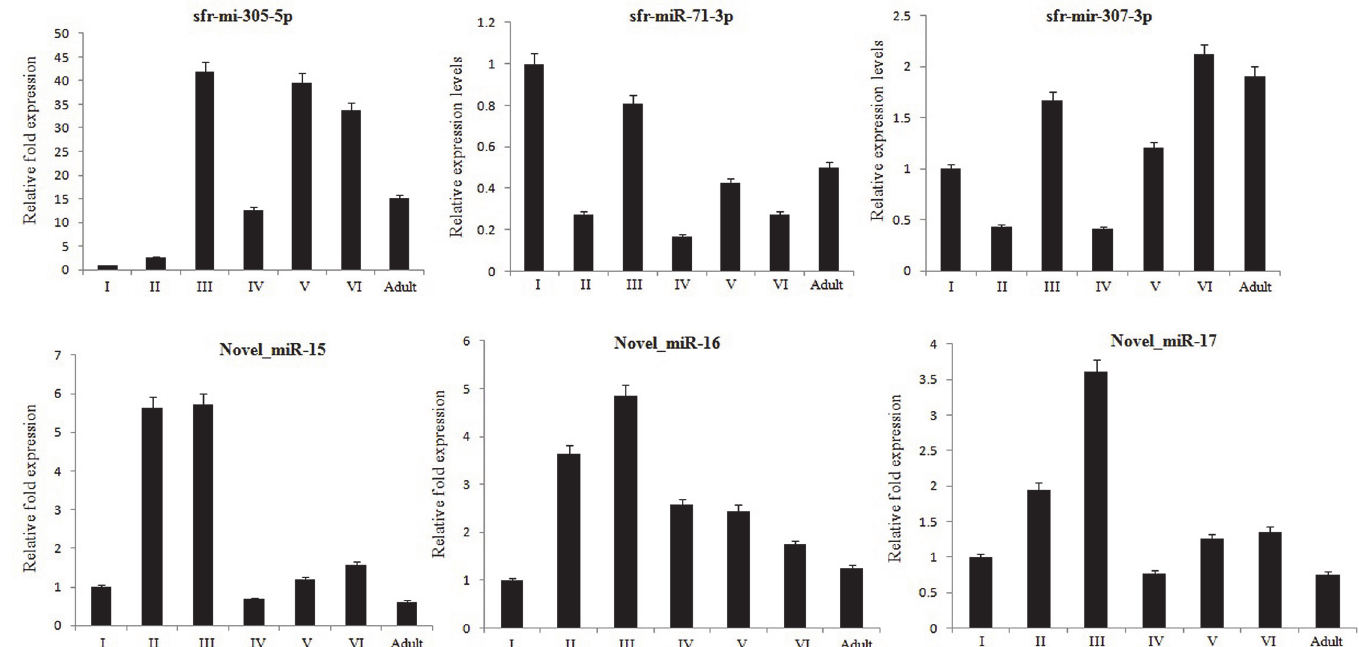
Fig 5. Expression levels of the selected miRNAs in developmental stages of S. litura . The absolute expression levels of the selected miRNAs with respect to U6snRNA (endogenous control) were analyzed by TaqMan miRNA assays using the total RNA isolated from each stage of the insect, S. litura . The bar graphs represent the expression level of each miRNA at a particular stage in comparison to the expression level in 1 st instar larvae. The statistical significance of the qRT analysis was determined by P value < 0.05 while the error bars represent the